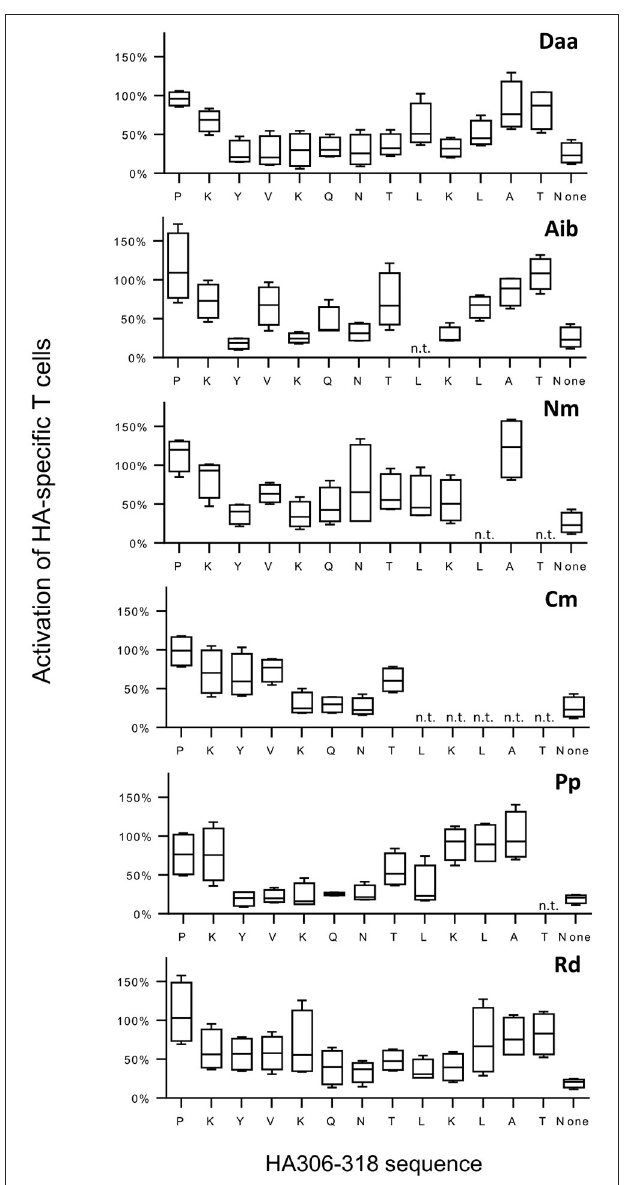
FIGURE 2 | In vitro antigenicity of modified HA analogs toward HA-specific memory T cells. After a short-term culture of PBMCs from 4 healthy donors with HA, CD4T cells were submitted to IFN- γ ELISPOT using HA, individual analogs or culture medium (“none” for “no peptide”). Data were reported as relative T-cell reactivity, corresponding to the ratio of the mean of IFN- γ spot numbers for the analog by the mean IFN- γ spot numbers for HA across the four healthy responding donors. Boxes extend from the 25th − 75th percentiles, the line in the middle of the box is plotted at the median and the whiskers go down to the smallest value and up to the largest. n.t., not tested. The HLA-DRB1 typing of the four donors were the following: donor A07 (04:01/11:01); donor A12 (03:01/13:03); donor A13 (01:01/15:01); and donor A18 (01:01/13:01).